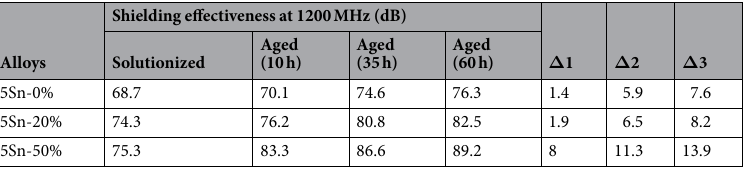
Table 4. EMI shielding effectiveness of Mg-5Sn alloy in various states. * Δ 1 = aged (10 h)–solutionized, Δ 2 = aged (25 h)–solutionized, Δ 3 = aged (60 h)–solutionized.